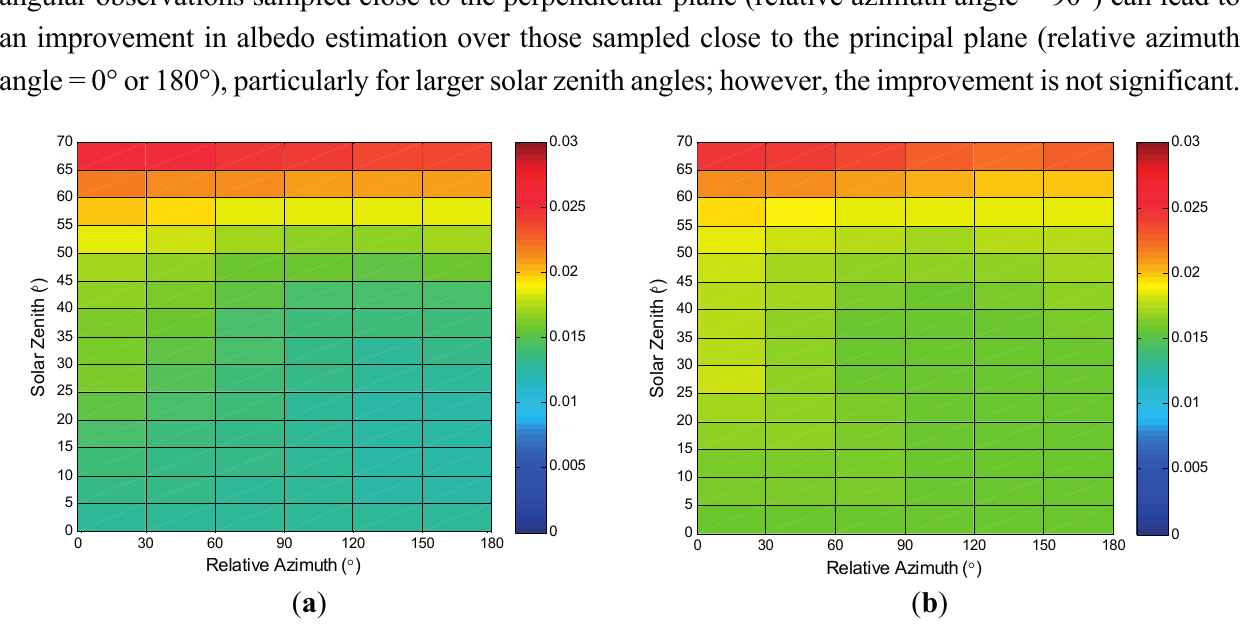
Figure 4. RMSEs of using simulated HJ TOA reflectance (view zenith angle = 25°) to estimate surface broadband shortwave albedos: ( a ) black-sky albedo; and ( b ) white-sky